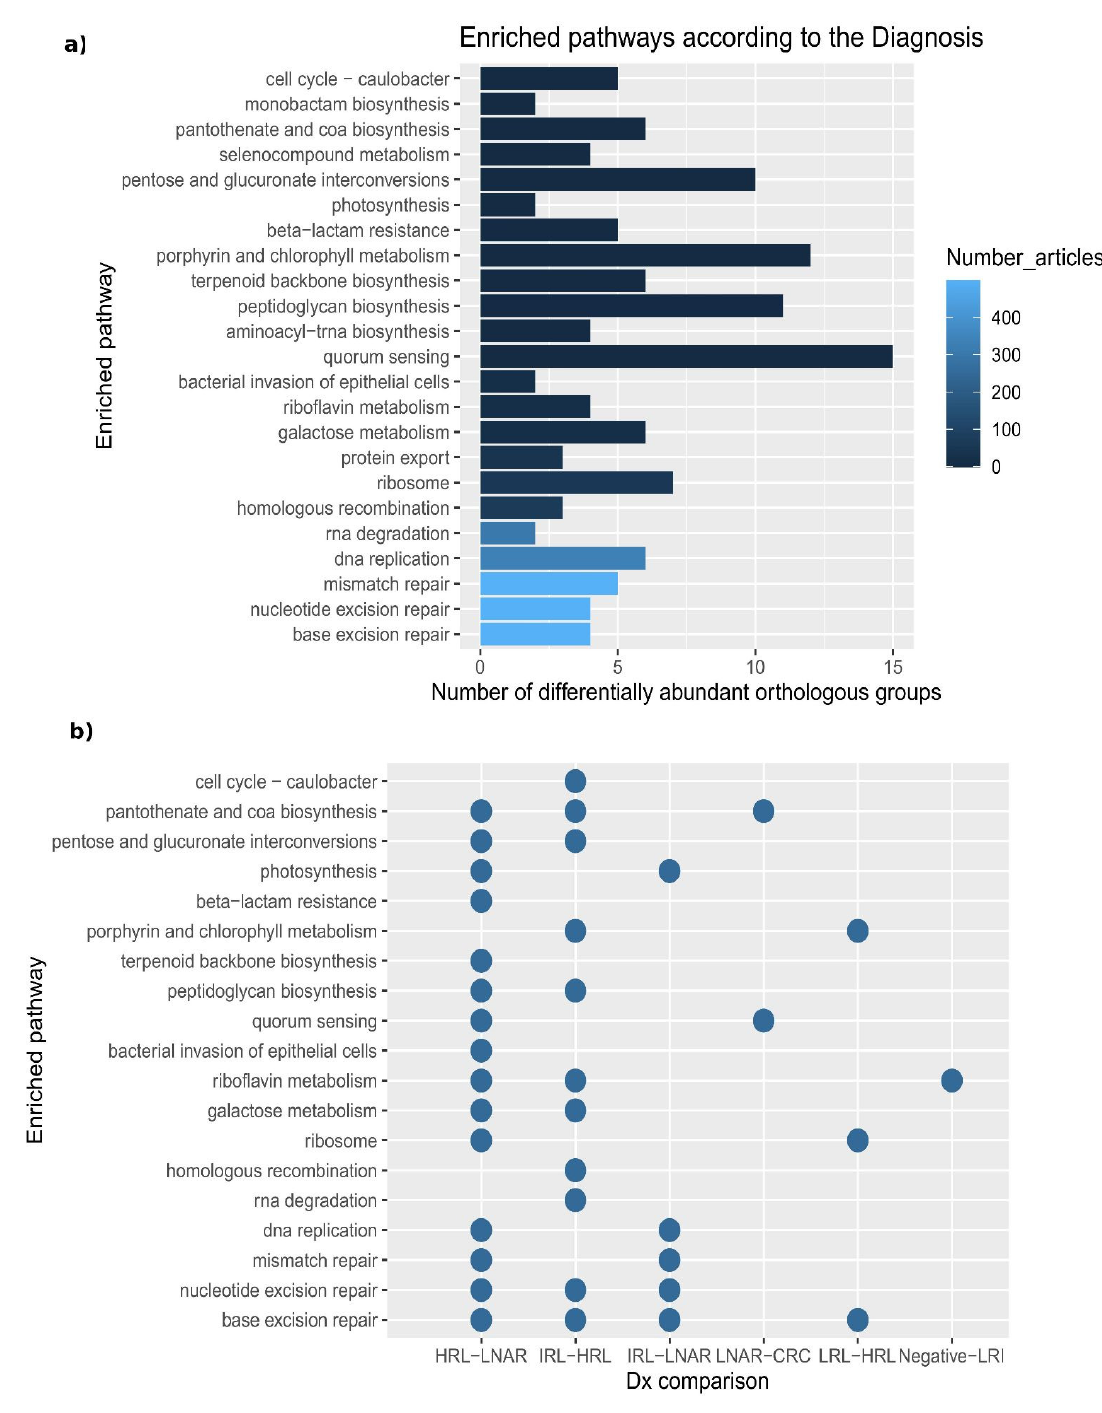
Figure 4. Enriched pathways according to the diagnosis. ( a ) The length of the bar indicates the number of differentially abundant OGs involved. The bars are sorted and colored according to the number of articles for which a given pathway has been linked to CRC. ( b ) Dotplot representing the pairs of diagnoses in which we found differentially abundant OGs involved in the enriched pathways. Of note, monobactam biosynthesis, protein export, selenocompound metabolism and aminoacyl-trna biosynthesis are not represented because multiple comparison tests did not detect involved OG as differentially abundant in any pairwise comparison.